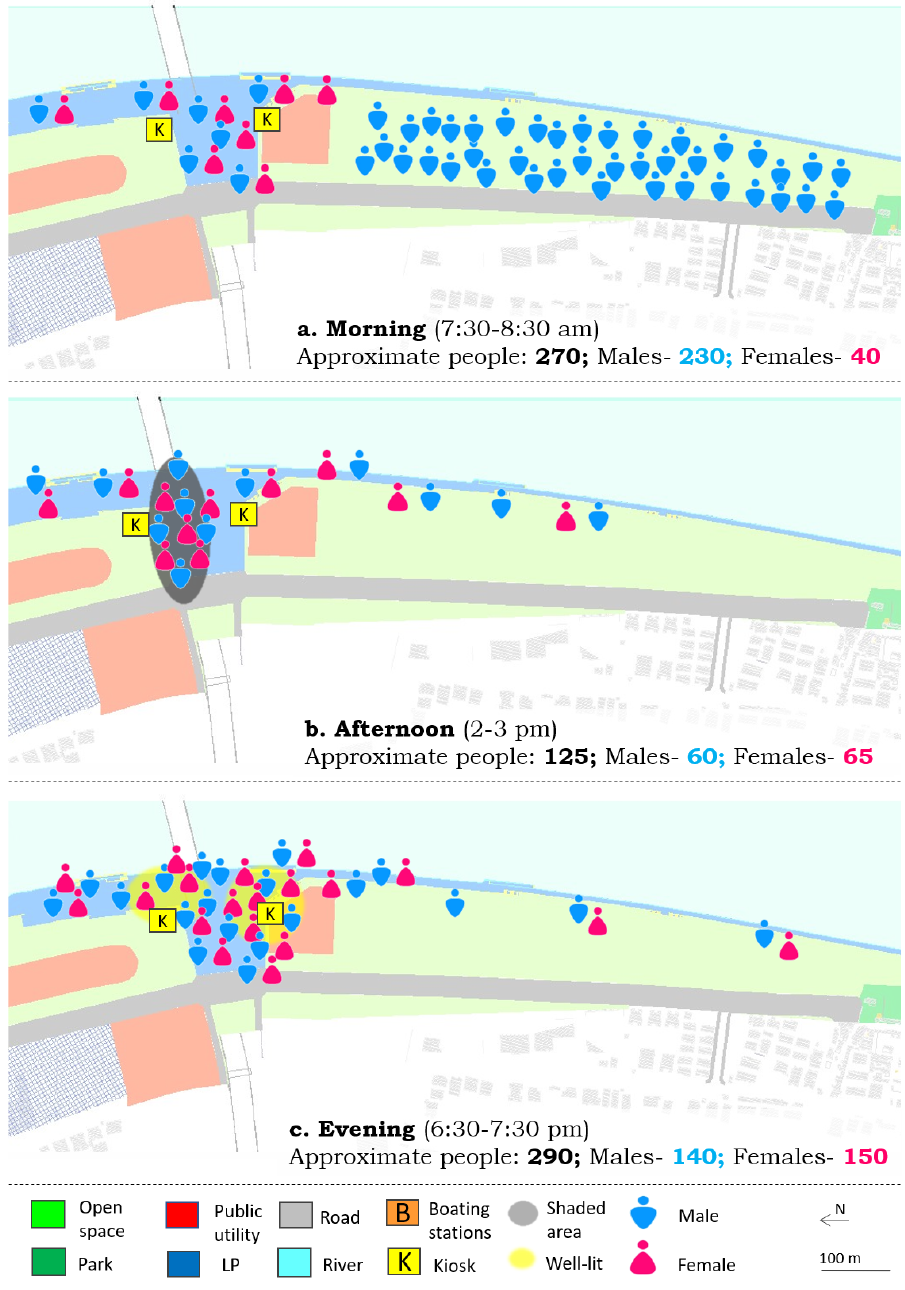
Figure 4. Gendered usage of space in Pocket